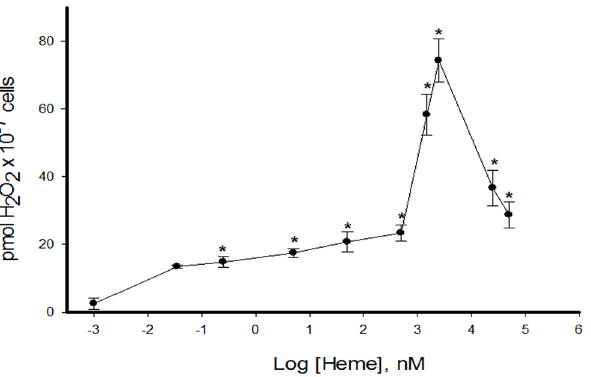
Fig 2. Effect of increasing concentrations of heme on the production of hydrogen peroxide by L . amazonensis . Living parasites were incubated for 20 min in the reaction medium with the addition of increasing concentrations of heme, as indicated on the abscissa. The values represent the mean ± standard error of at least three independent experiments. * Statistically significant when compared to control (P < 0.05).